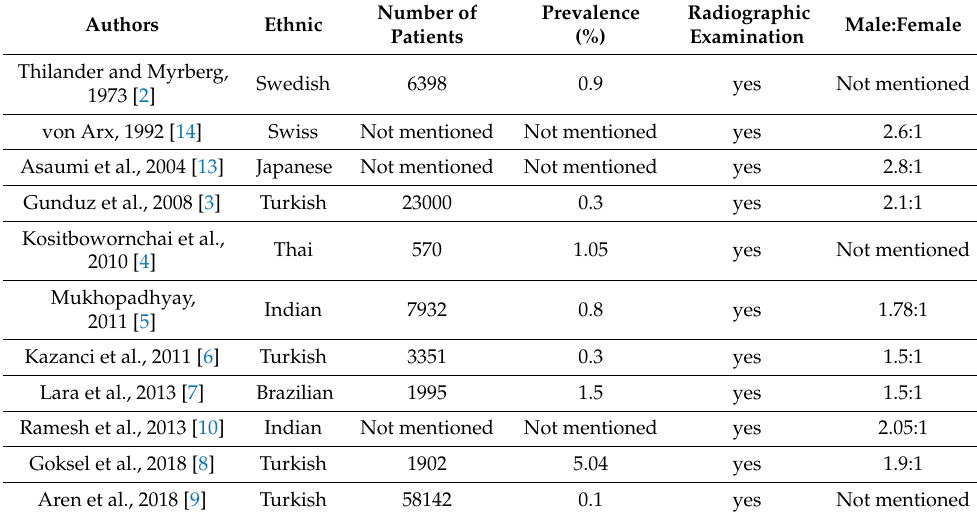
Table 1. The prevalence of mesiodens in different